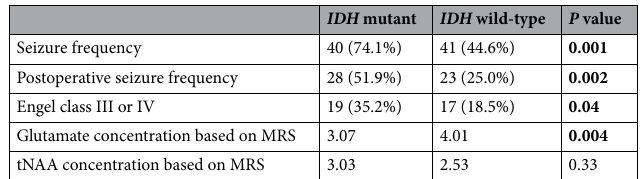
Table 3. Comparisons between IDH mutant and wild-type gliomas. bold values indicate in p < 0.05 and consequently two analyzed categories were considered to be significantly different. IDH isocitrate dehydrogenase ; tNAA total N